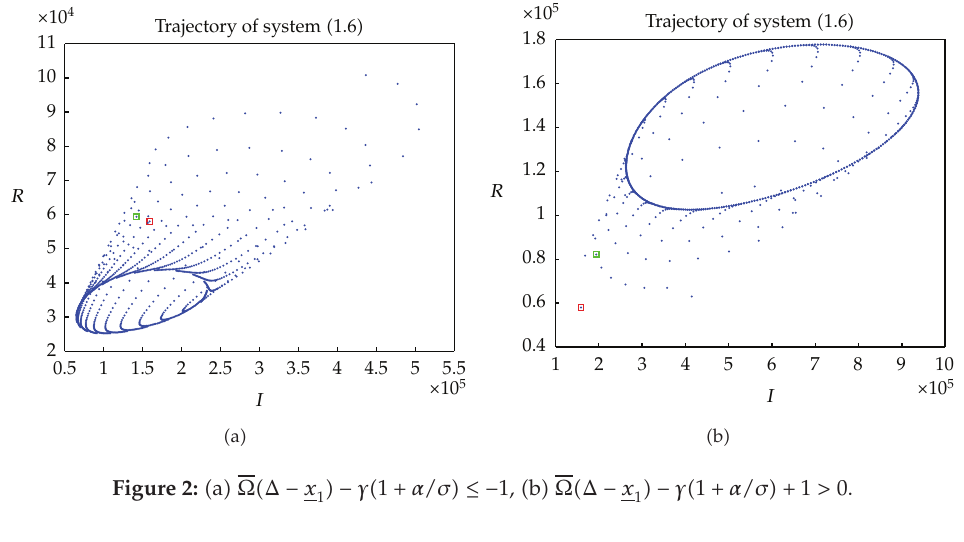
(cid:5) − γ (cid:2) 1 (cid:7) α/σ (cid:5) ≤ − 1, (cid:2) b (cid:5) Ω(cid:2)Δ − x Figure 2: (cid:2) a (cid:5) Ω(cid:2)Δ − x 1 Trajectory of system ( 1.6 )